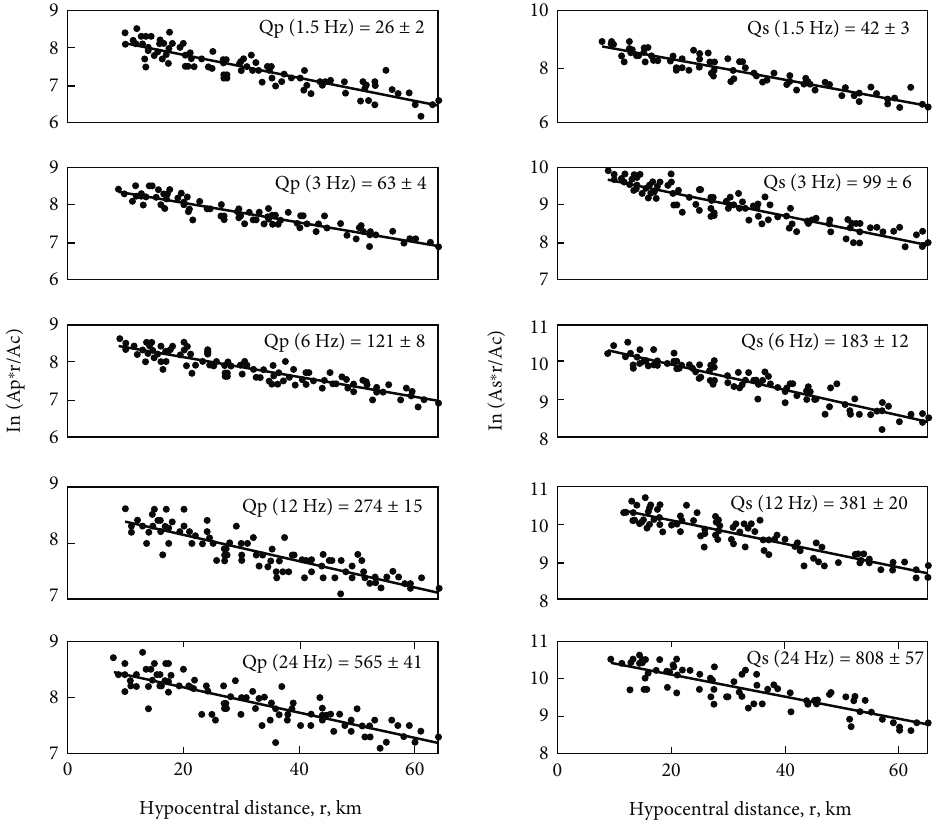
Figure 6: Plots of normalized P and S wave amplitudes with hypocentral distance at di ff erent frequencies and for all seismic stations. The regression lines and estimated Q